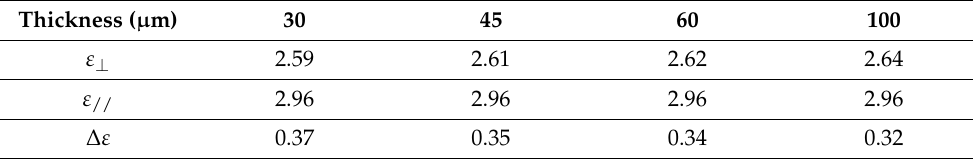
Table 3. Dielectric properties of the E7 LC with different